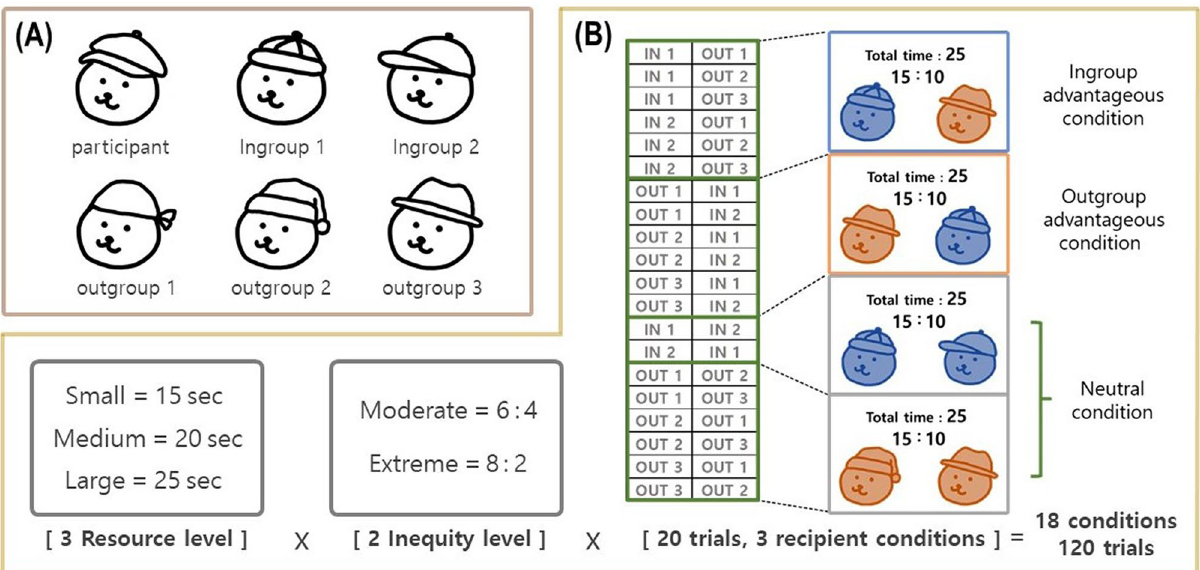
Figure 1. Schematic diagram of the experimental paradigm. ( A ) Six bear characters indicate the participants and the other five players. The red and blue colors were used to indicate their group membership (i.e., ingroup or outgroup), counterbalanced across participants. ( B ) The combination of three resource levels, two inequality levels, and three recipient types made up 18 conditions, with a total of 120 trials.